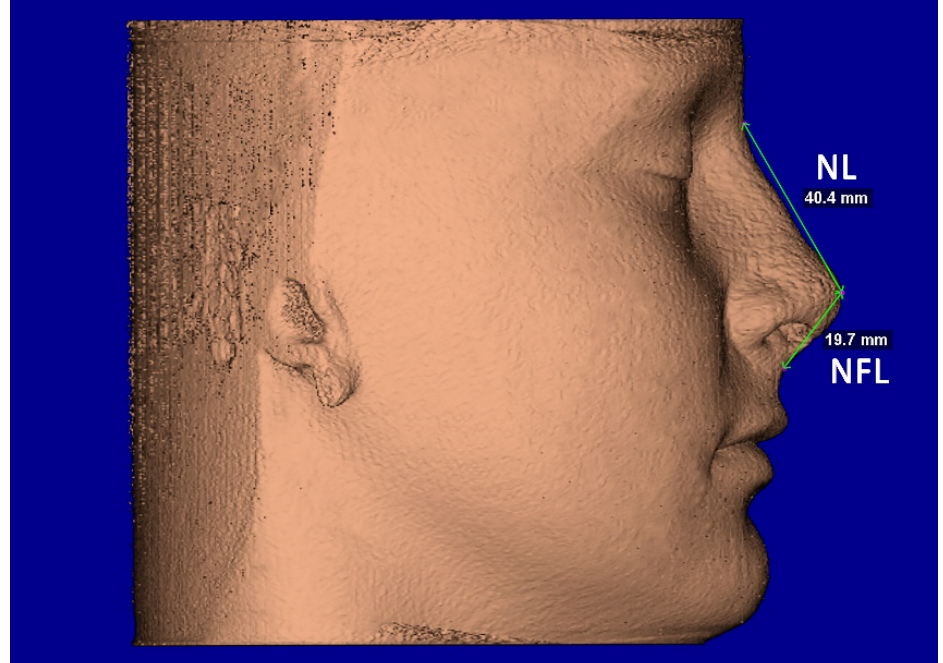
Figure 6. Facial soft-tissue linear measurements of the length of the nose (NL) and length of the nasal filter (NFL).